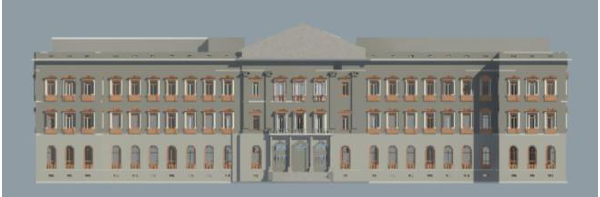
Figure 3. Naples Front of the Federico II building on corso Umberto I. 3D model